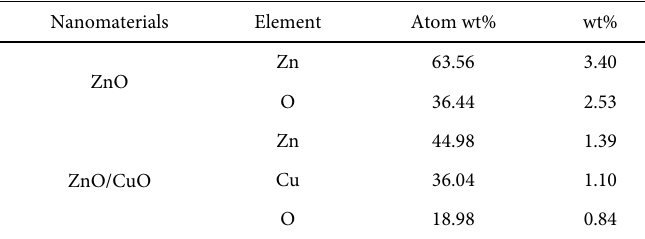
Table.1. Elemental composition in synthesized ZnONPs and ZnO/CuO-3